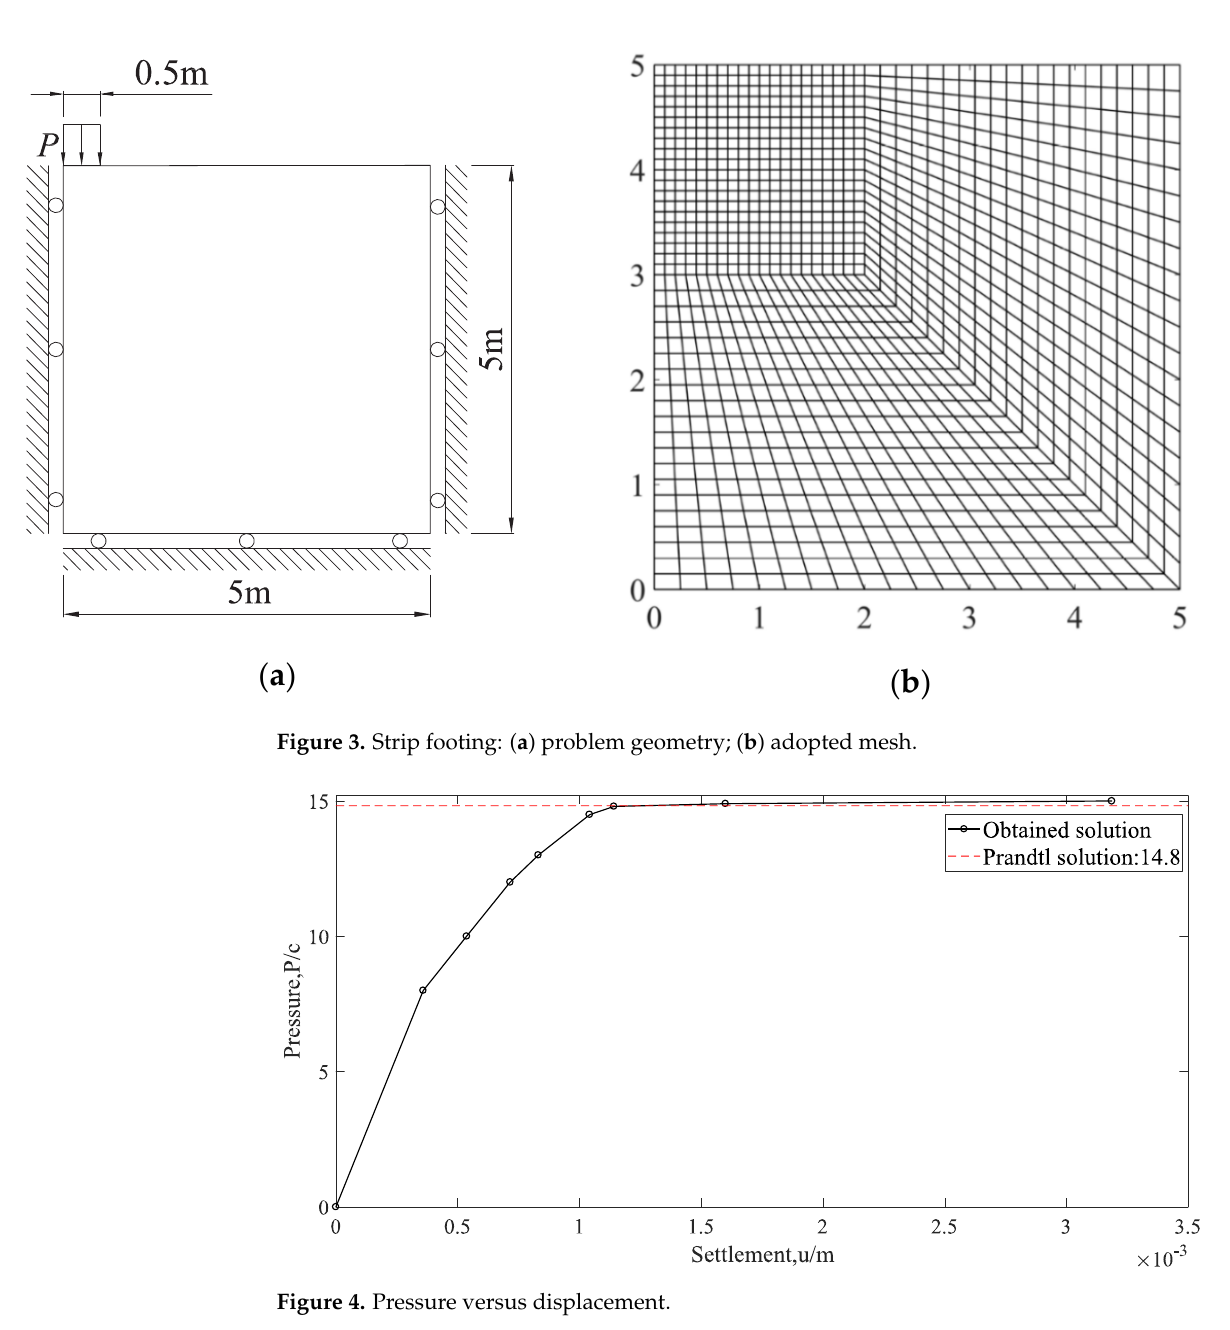
Figure 4. Pressure versus displacement.